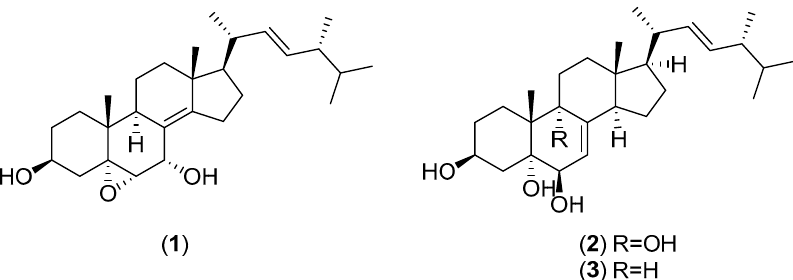
Figure 3. Chemical structures of selected compounds isolated from Agaricus silvaticus.